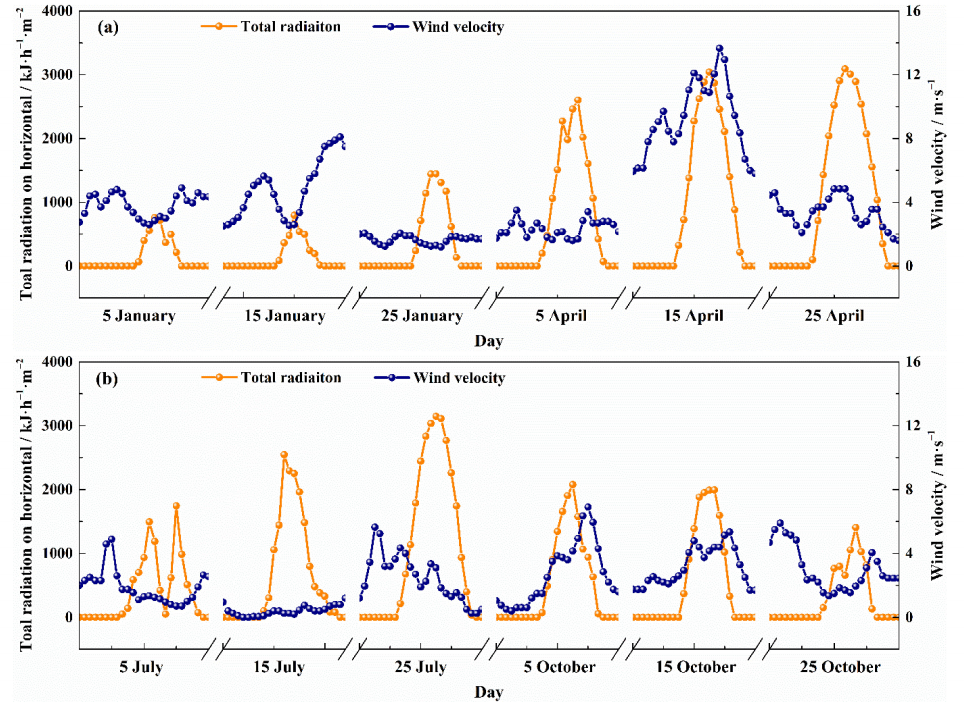
Figure 7. Daily radiation and wind velocity of different months in Kaba-He: ( a ) 5/15/25 January and 5/15/25 April; ( b ) 5/15/25 July and 5/15/25